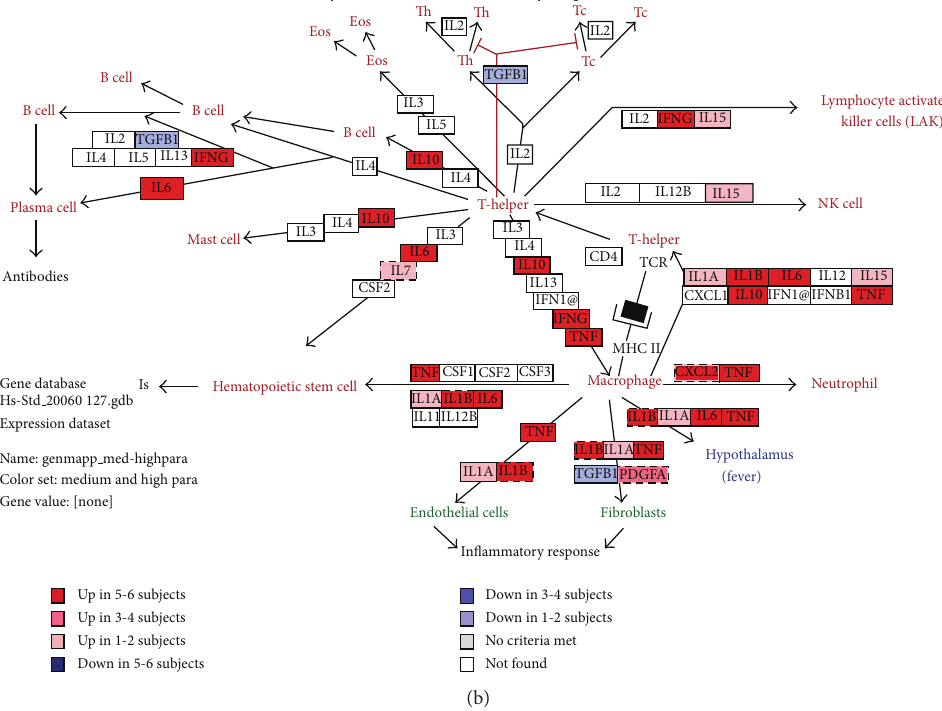
Figure 3: Inflammatory and cytokine response pathways. GenMAPP illustration of genes upregulated with low parasitemias (a) and medium to high parasitemias (b). Several genes were upregulated more frequently with medium or high parasitemias (b) than low parasitemias (a). Among these were IL-1 𝛽 , IL-6, IL-10, TNF, and INF- 𝛾 . Additionally, a number of genes, including IL-7, IL-15, and PGDFA (platelet-derived growth factor alpha polypeptide), were downregulated with low parasitemias and upregulated with medium to high parasitemias. TGF- 𝛽 was downregulated more with medium to high than low